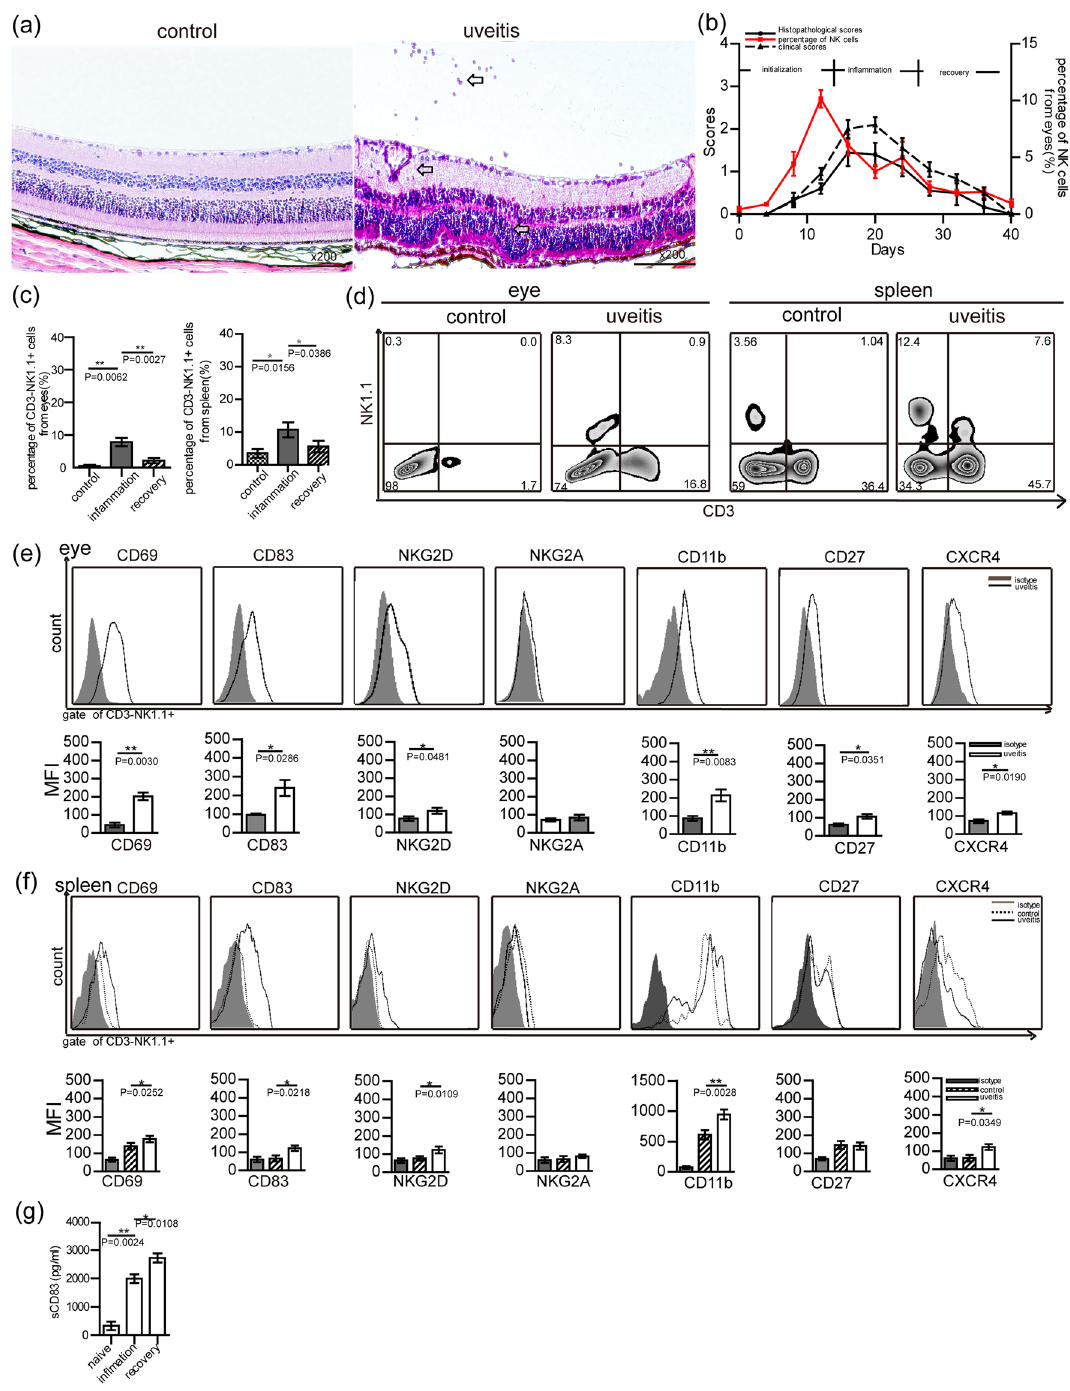
Figure 1. CD83 + NK cell numbers were increased in inflamed eyes and spleen cells within the EAU model. ( a ) Histopathology of a representative eye section from control (Day 0) and immunized mice on day 16 (hematoxylin and eosin, original magnification, × 200). Infiltrating lymphocytes, vasculitis and photoreceptor folding within the retina were found in the inflamed eye (hollow arrows). ( b ) Histopathological scores were evaluated in the development of uveitis disease (Three mice were used at every time point, and three separate experiments were repeated, as indicated by the black line), while the percent of CD3 − NK1.1 + cells was determined within infiltrating cells in the eyes (red line). ( c ) The percent of CD3 − NK1.1 + cells in total number of infiltrating eye or spleen cells of immunized mice as detected at the inflammatory (day 12–16) or recovery (day 28) stages, and compared with those in untreated naive mice (A total of ten mice/group were used and experiments were replicated three times, values represent the mean ± s.e.m., * P < 0.05, ** P < 0.01). ( d ) The percent of CD3 − NK1.1 + cells in inflamed eyes or spleen from a representative EAU and control mouse. ( e ) Expressions of CD69, CD83, NKG2D, NKG2A, CD11b, CD27 and CXCR4 in infiltrating CD3 − NK1.1 +